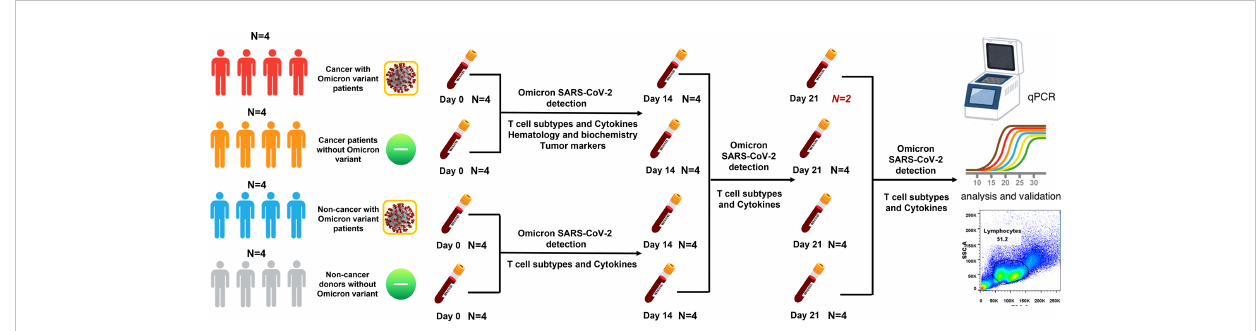
FIGURE 1 Study pro fi le. There were four groups in this study. Group 1: cancer patients with omicron infection; Group 2: cancer patients without omicron infection; Group 3: non-cancer patients with omicron infection; and Group 4: non-cancer-af fl icted subjects without omicron infection.